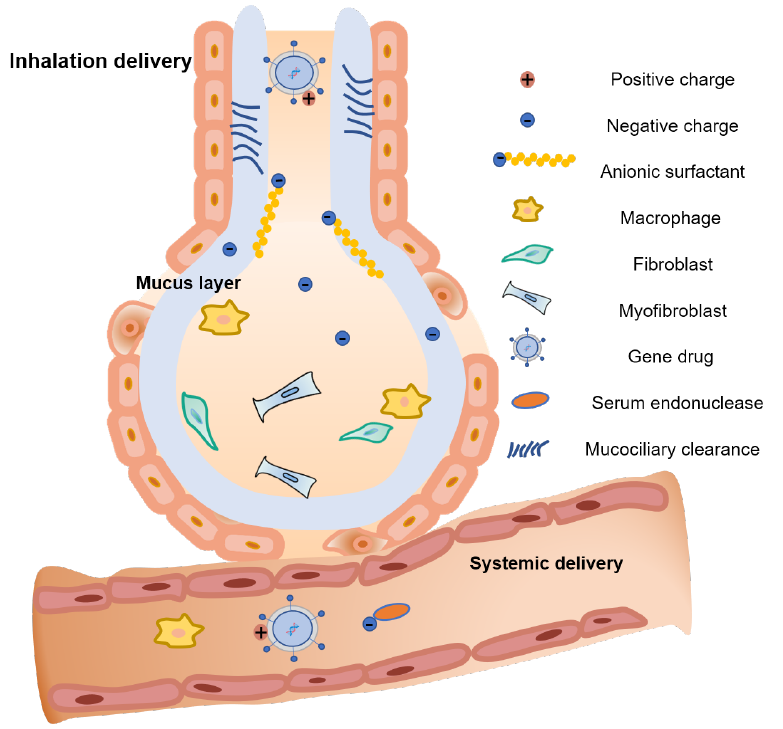
Figure 2. Barriers for the gene therapy of pulmonary fibrosis.